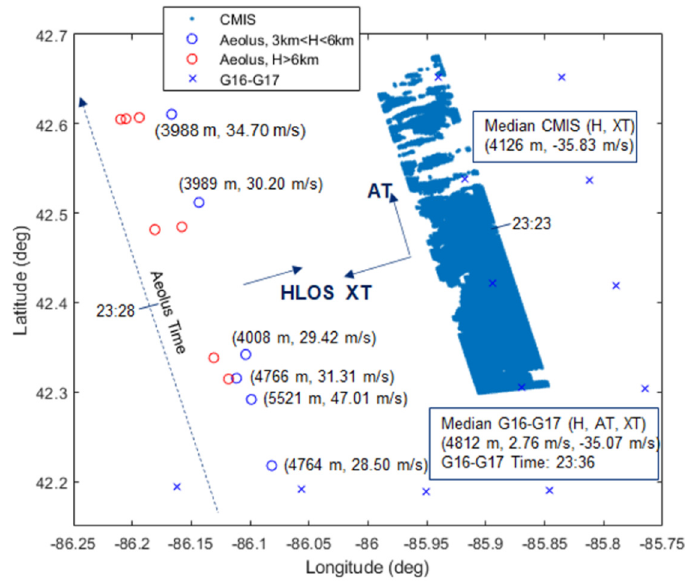
Figure 17. Retrieval sites for Aeolus, GOES stereo, and CMIS wind retrievals are indicated, showing a vast difference in sampling densities between the aircraft and satellite observations. GOES stereo wind statistics are computed over a larger domain (1.5° latitude × 1° longitude) containing 32 GOES stereo retrievals, compared to several thousand CMIS retrievals.